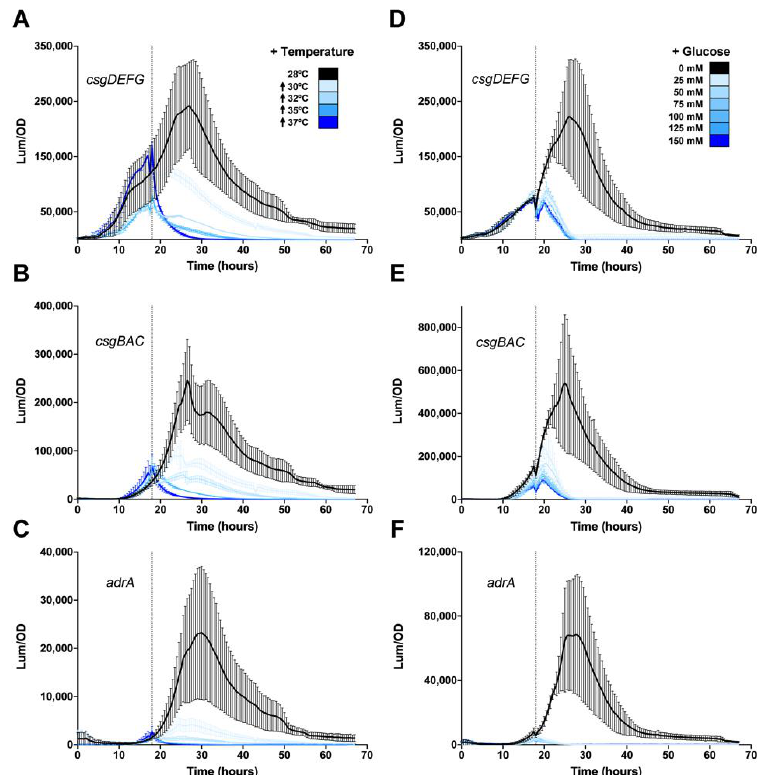
Figure 4. The csgD biofilm network in Salmonella is repressed by the addition of glucose or an increase in growth temperature. Expression of csgDEFG ( A , D ), csgBAC ( B , E ), and adrA ( C , F ) was measured during growth of S. Typhimurium 14028 at 28°C for 18 h prior to temperature shift ( A – C ) or the addition of 25, 50, 75, 100, 125, or 150 mM glucose ( D – F ). The vertical dotted line represents the time of temperature shift or glucose addition. For each graph, luminescence divided by the optical density at 600 nm (Lum/OD) is plotted as a function of time and each curve represents a single growth condition. The mean and standard deviations are plotted from three biological replicate experiments measured in triplicate.